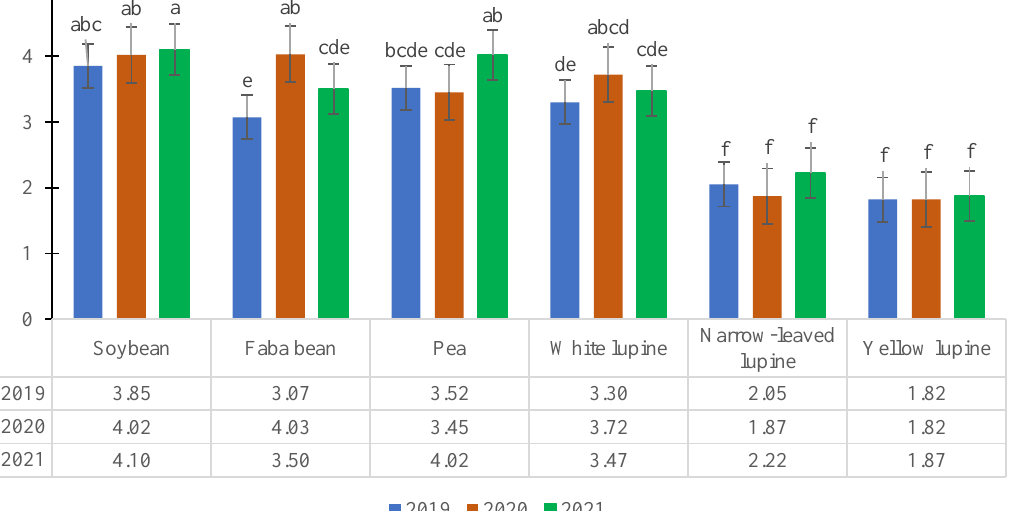
Figure 2. Seed yield in t ha − 1 . Different lowercase letters indicate significant differences ( p < 0.05) according to the analysis of variance (ANOVA). The standard error is marked on the bars.